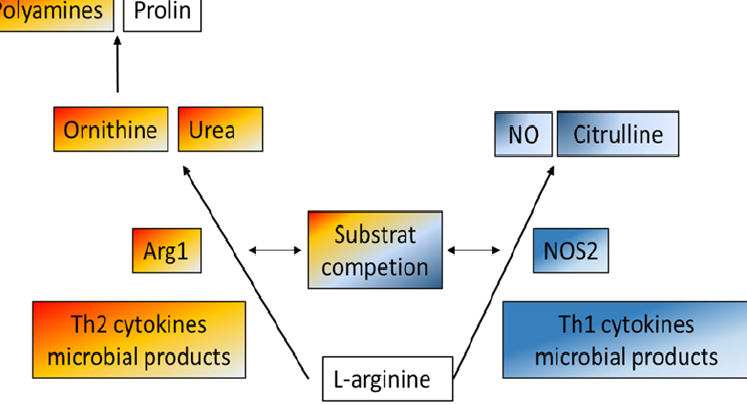
Figure 1. Metabolism of L -arginine-schematic and simplified overview of two main enzymatic pathways: Arg1 and NOS2 compete both for the common substrate L -arginine. While NOS2 converts L -arginine into citrulline and NO, known for potent antimicrobial and immunoregulatory activities, Arg1 metabolizes this semi-essential amino acid into proline and polyamines, which drive cell proliferation and collagen synthesis, but also in immune cell dys-function